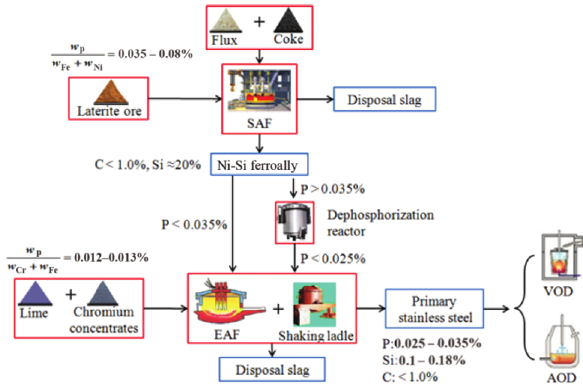
Figure 1: Flow diagram of electrosilicothermic process for 300 series stainless steel production.